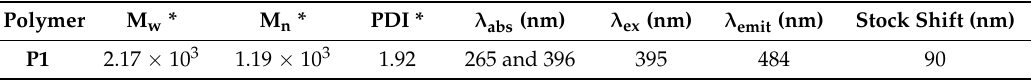
Table 1. Radical polymerization data and photophysical properties of polymer P1